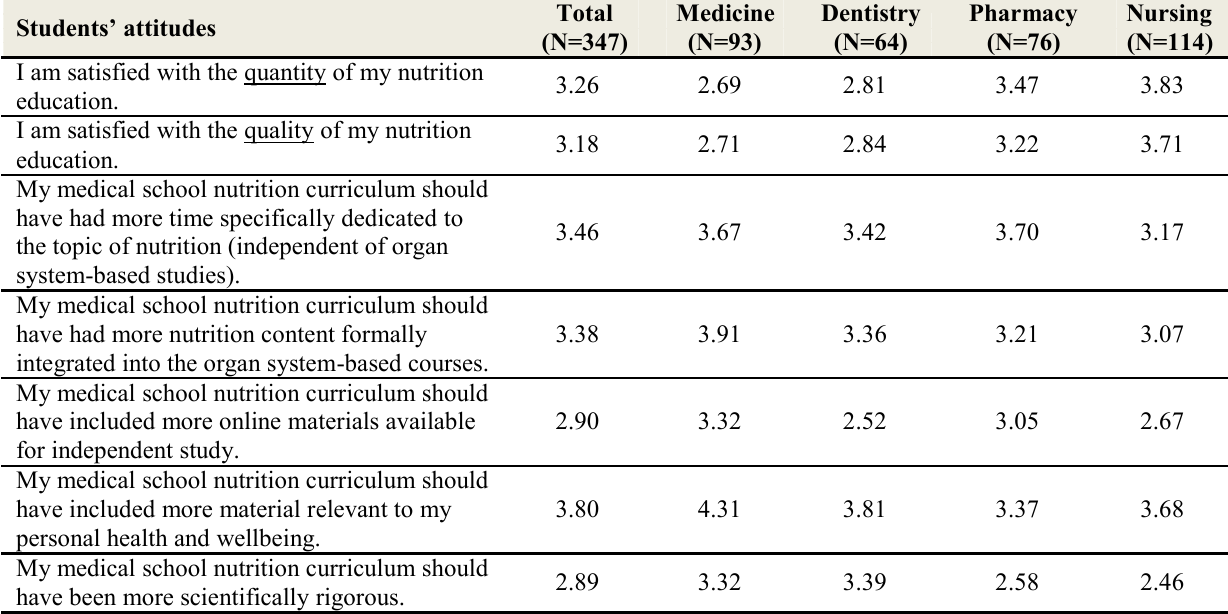
Table 1. Students’ attitudes about their education in the discipline of nutrition Total Medicine